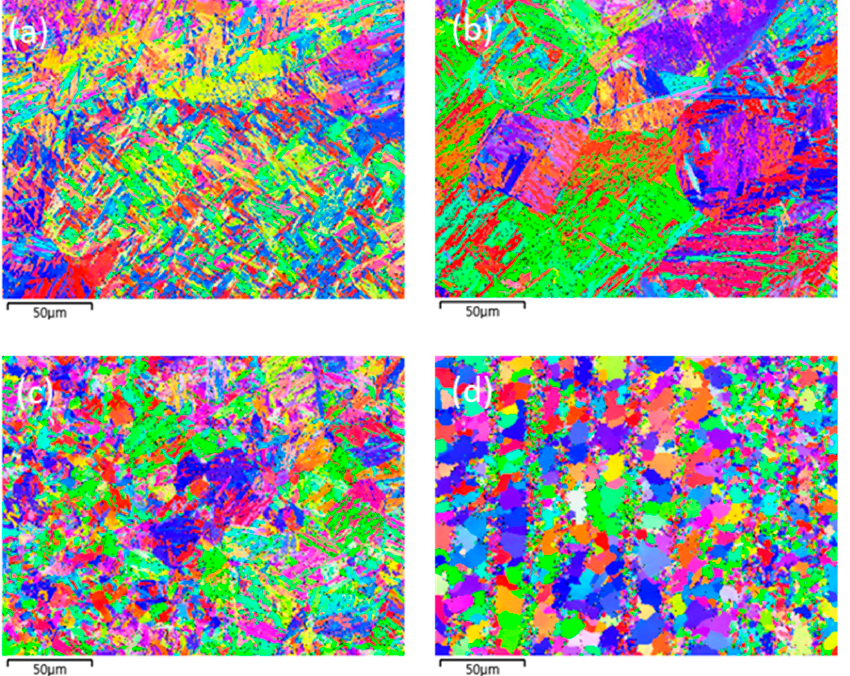
Figure 15. EBSD image of grain morphologies in the welded joint: ( a ) point1, ( b ) point2, ( c ) point3 and ( d ) point4.